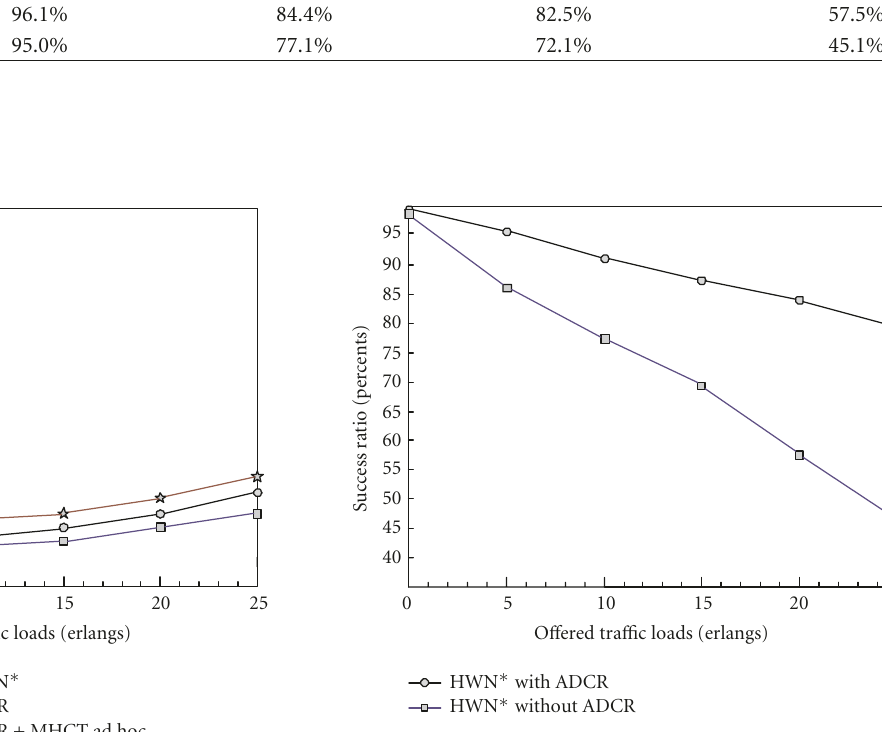
Figure 14: Comparisons of success route acquire ratio between HWN ∗ ADCR and HWN ∗ without